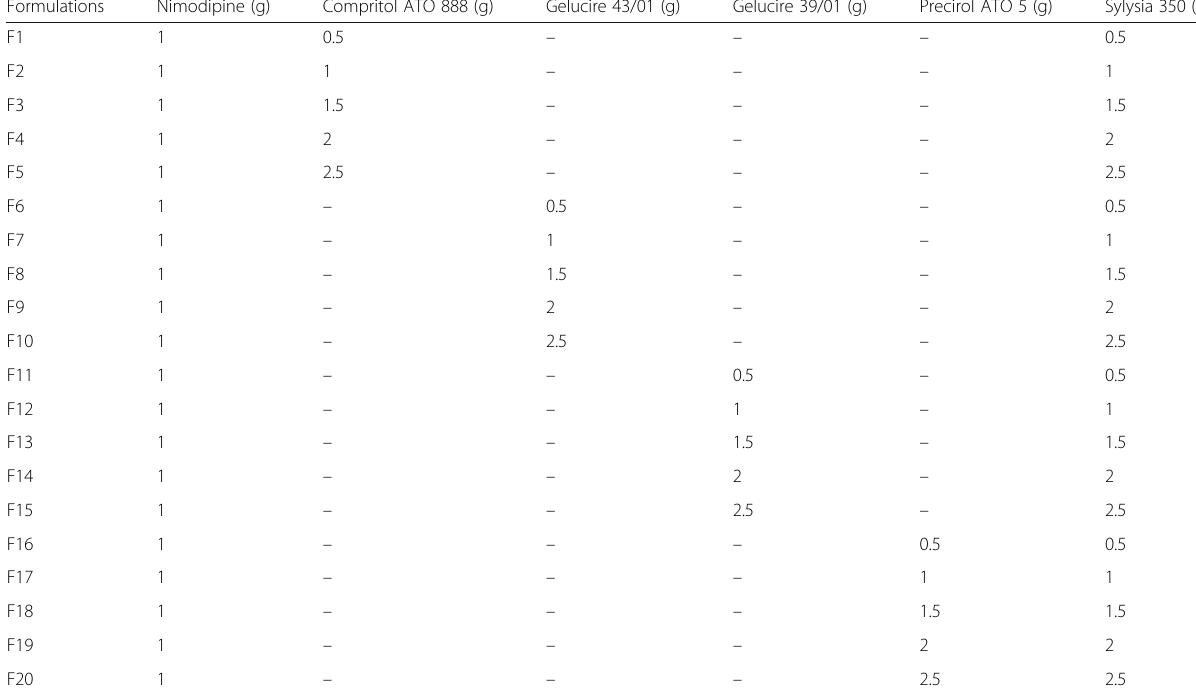
Table 1 Composition of nimodipine solid dispersion systems Formulations